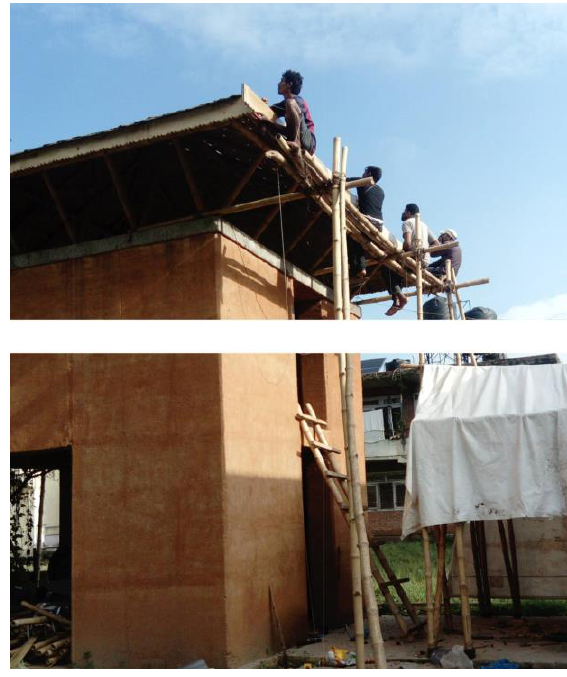
Figure 10. Examples of